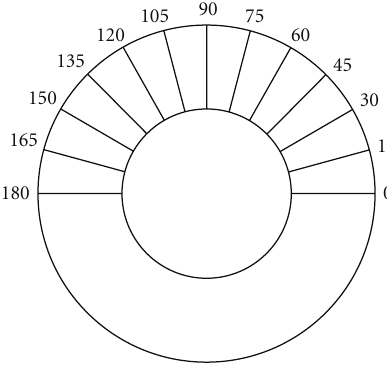
Figure 3: Locations where the velocity profiles are displayed.